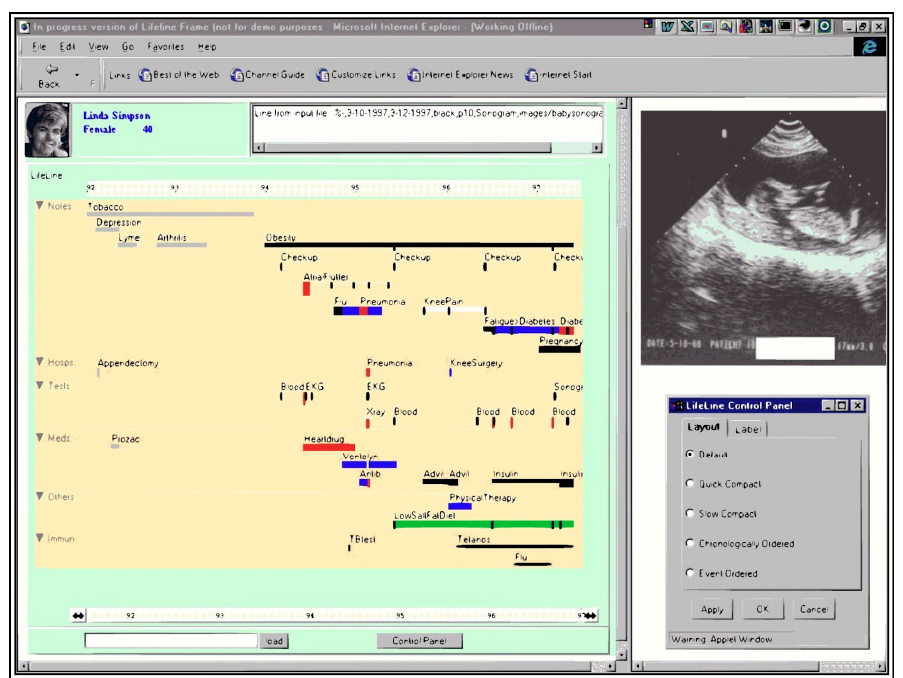
Figure 14. Lifelines: interactive visualization tool that displays patient’s medical histories on a timeline. Source: image courtesy of the University of Maryland Human–Computer Interaction Lab, http://hcil.umd.edu.